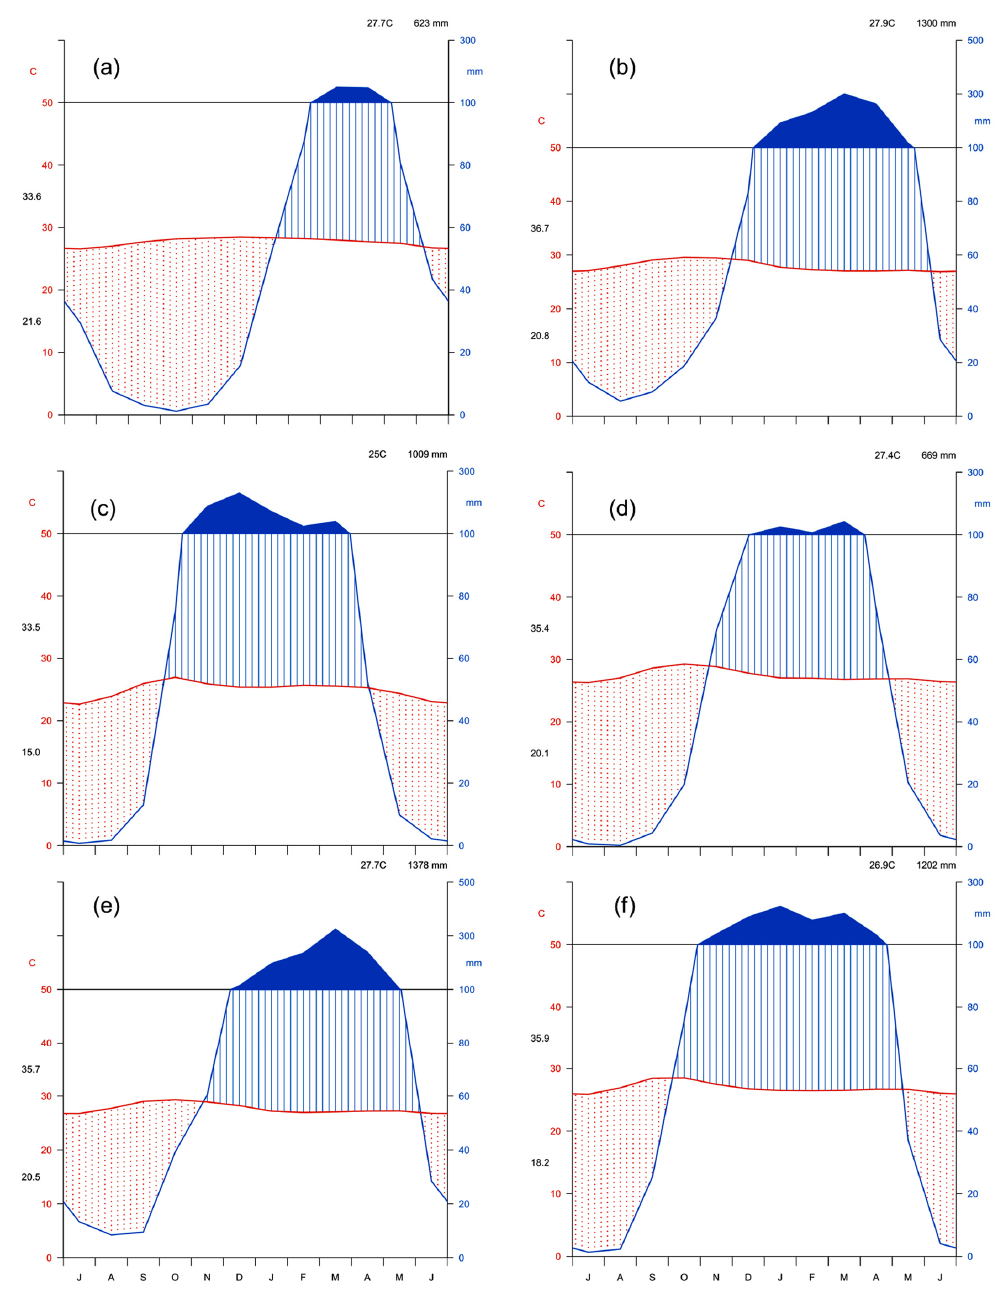
Figure 5. Walter–Lieth climatic diagrams for the 1980–2013 period at: ( a ) Carnaubais (benchmark site # 1); ( b ) Campo Maior (benchmark site # 2); ( c ) Correntina (benchmark site # 3); ( d ) São Raimundo Nonato (benchmark site # 4); ( e ) Esperantinópolis (benchmark site # 5); and ( f ) Fazendas do Piauí (benchmark site # 6). Locations of benchmark sites are shown in Figure 1a. The black horizontal line indicates monthly precipitation greater than 100 mm and the graph over it is filled in solid blue. When P < 2T, where P is monthly mean precipitation, and T monthly mean temperature, there is a dry period (filled in dotted red vertical lines). Otherwise, the period is considered wet (filled in blue lines). Daily maximum average temperature of the hottest month and daily minimum average temperature of the coldest month are labeled in black at the left margin in each diagram.